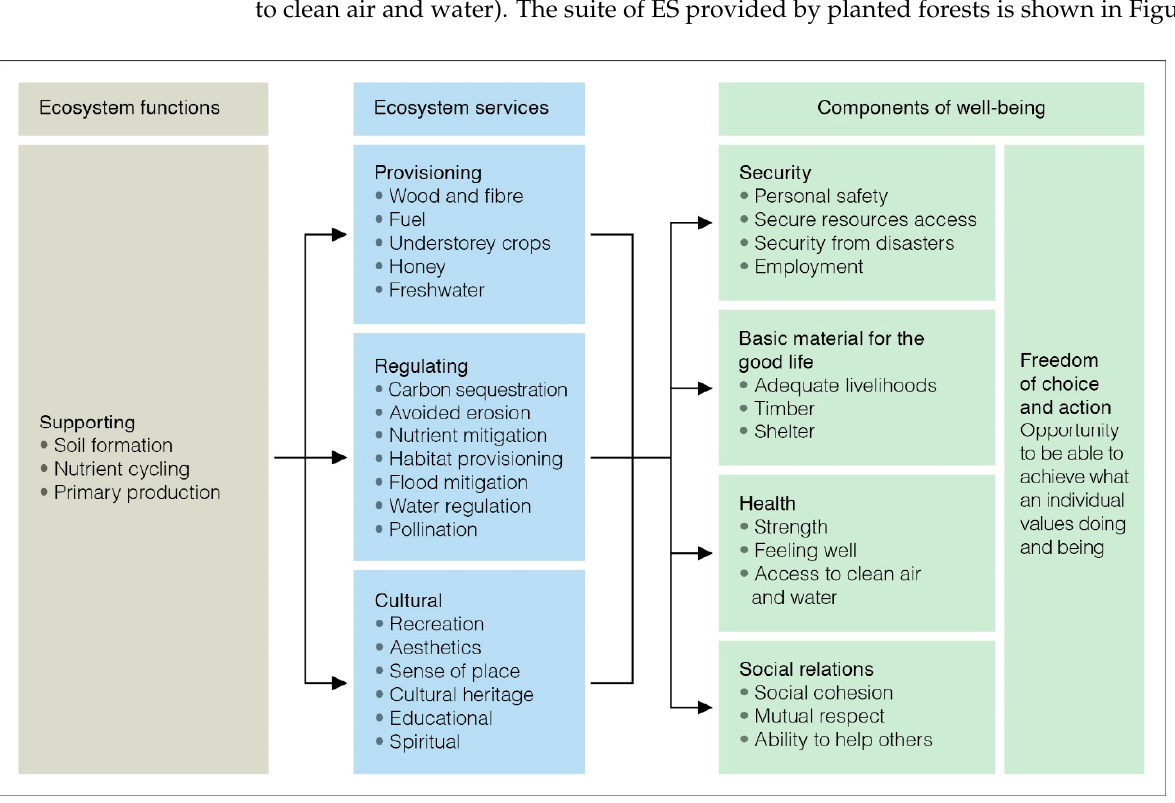
Figure 1. Ecosystem services provided by planted forests and their contributions to human well-being (Adapted from MEA [10], Yao, Barry [58], and Haines-Young and Potschin [12]).